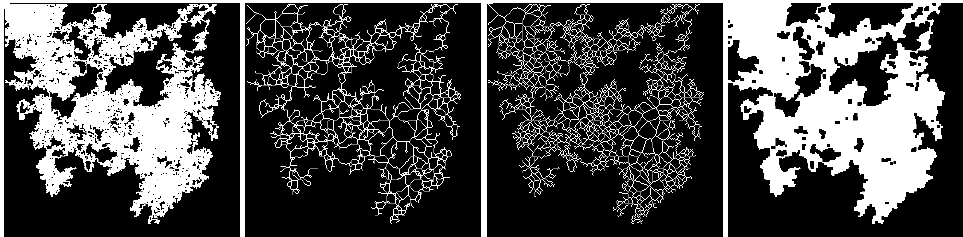
Figure 4. Random walk (RW) mask (leftmost) with three morphological variations: skeletonization (RW + SK), medial axis transform (RW + MAT) and dilation (RW + DIL). Besides covering different areas of missing pixels, these masks simulate various patterns characteristic to artwork degradation: moist and pest formation, craquelure, and mechanical